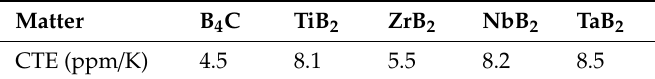
Table 5. Comparison of thermal expansion coe ffi cients (CTE) of boron carbide and the relevant transition metal borides